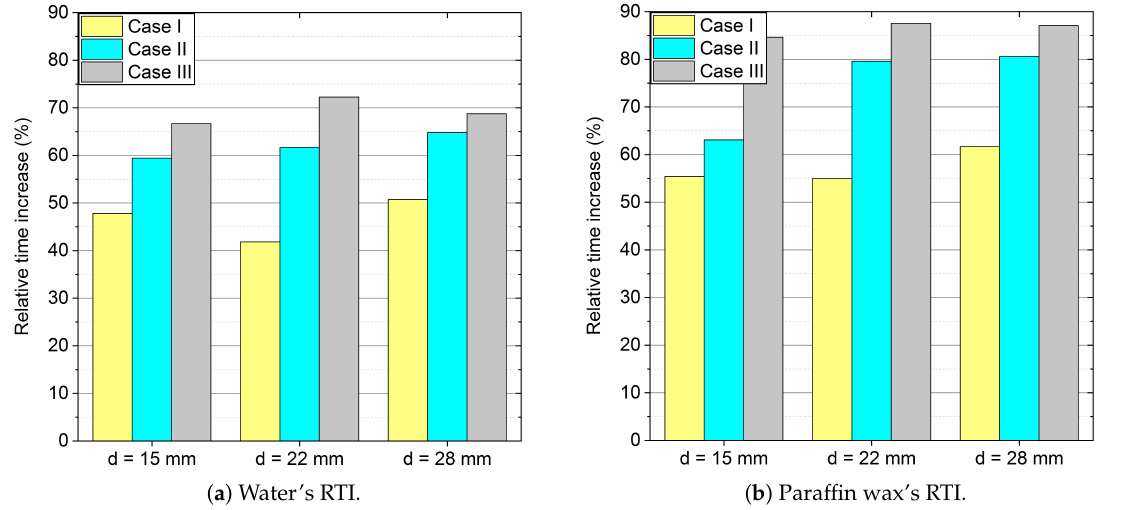
Figure 13. Relative time increase ( RTI ) for analysed Cases: ( a ) water and ( b ) paraffin